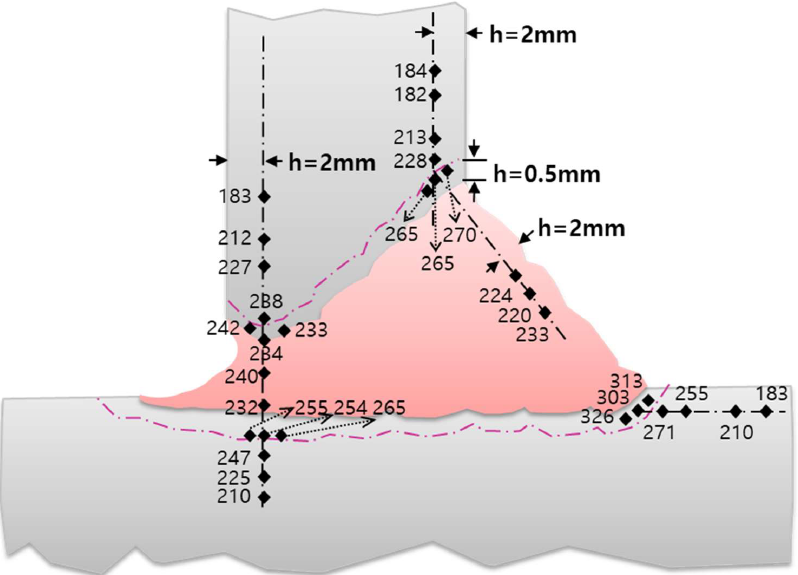
Figure 10. Hardness distribution of the welded T-joint with the 30 mm thick plate preheated up to 50 °C.